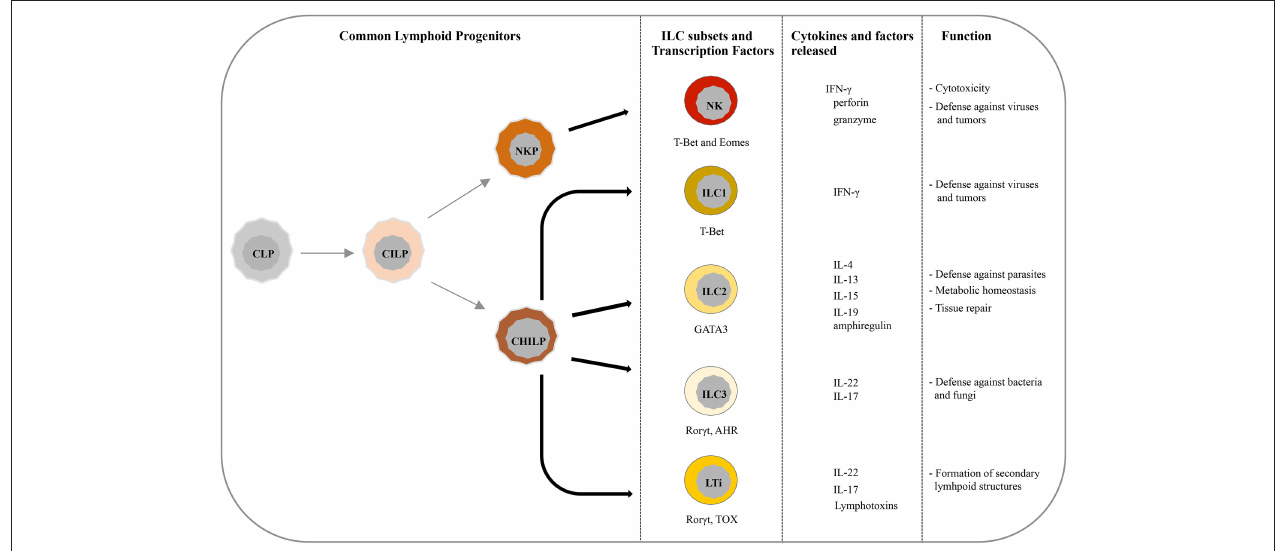
FIGURE 1 | Current view of differentiation and immune function of ILC subsets. ILCs originate from common lymphoid progenitors (CLPs) that give rise to common innate lymphoid progenitors (CILPs). On one side, CILPs can differentiate into NK precursor (NKP) that, through T-bet and Eomes, will originate NK cells, and on the other side into common helper innate lymphoid precursors (CHILP) from which originate both Innate lymphoid precursors (ILP) and lymphoid tissue inducer progenitors (LTiP). ILC1/2/3 subsets and LTi cells differentiate, according to the different transcription factors required, from ILP and LTiP precursors, respectively. As specified in the text, NK/ILC cells release various cytokines and exert different immune